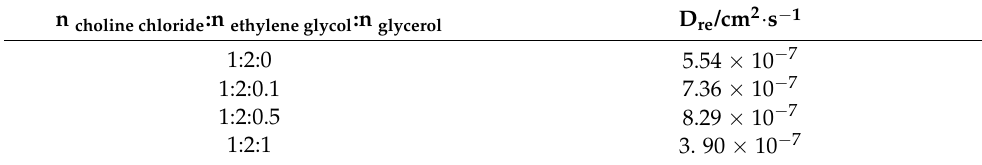
Figure 5. ( a ) Cyclic voltammogram of the DESs with 0.1 mol·L − 1 FeCl 3 ·6H 2 O in different tempera- tures at the scan rates of 50 mV·s − 1 ; ( b ) electrochemical impedance spectroscopy of the DESs with 0.1 mol·L − 1 FeCl 3 ·6H 2 O dissolved. Table 2. Diffusion coefficient in different molar ratio of the DESs with 0.1 mol · L − 1 FeCl 3 · 6H 2 O. n choline chloride :n ethylene glycol :n